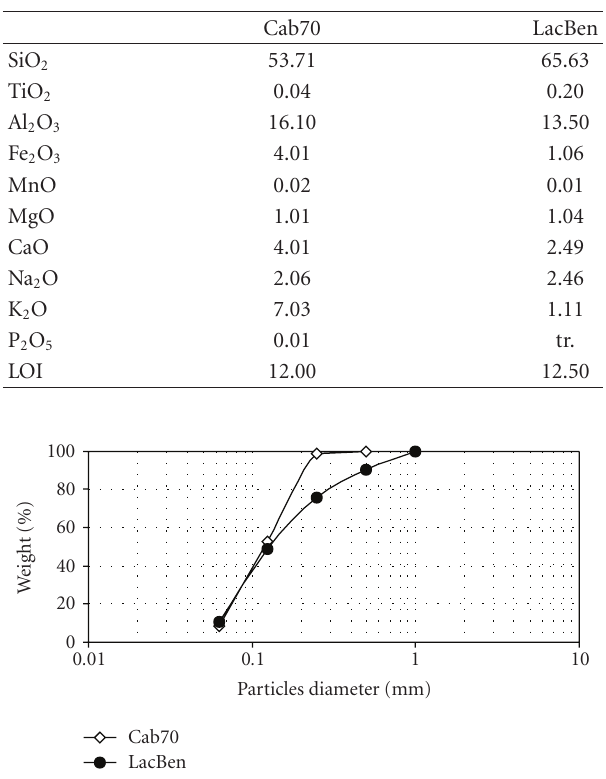
W2 clay (weight 20%), quartz sand (15 weight %), aplite (10 weight %), L11 albite (25 weight %), and S pegmatite (10 weight